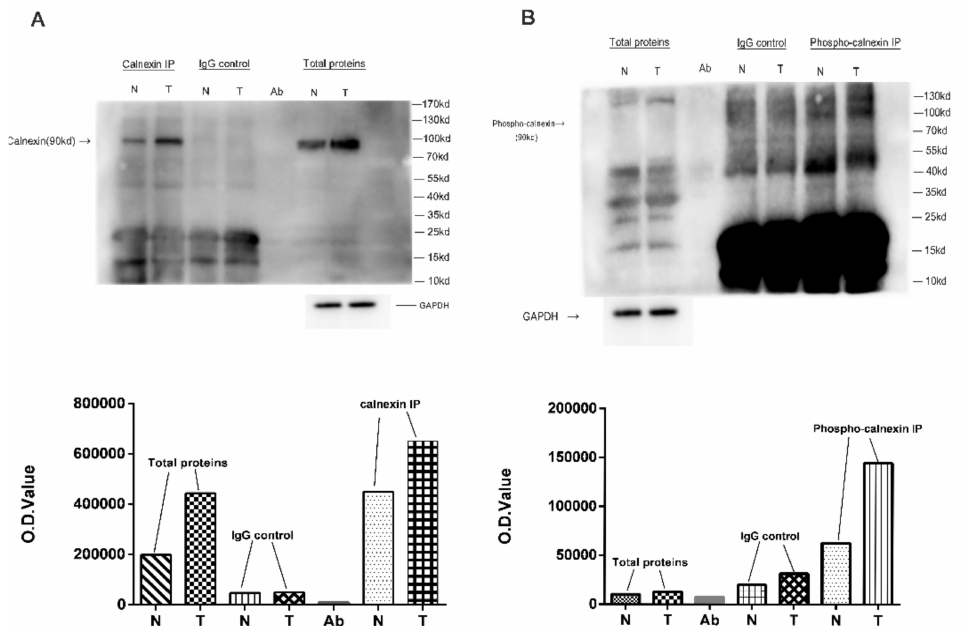
Figure 5. Semiquantitative analysis of phosphorylated calnexin between NF-PitNETs and controls. The total proteins were extracted from NF-PitNETs (T) and control pituitary tissues (N). Calnexin was immunoprecipitated from the total proteins (T: n = 1.5 mg; N: n = 1.5 mg) with anti-calnexin antibodies (6 µ g). For the negative control experiment to test the specificity of anti-calnexin antibodies, IgG (6 µ g) was used to replace anti-calnexin antibodies for immunoprecipitation. ( A ). Half of the IP product was used to detect the expression level of calnexin in NF-PitNETs (T) and control pituitary tissues (N) with another different anti-calnexin antibody. A portion of anti-calnexin antibodies (Ab: n = 1 µ g) and total proteins (N: n = 20 µ g; T: n = 20 µ g) were used as the control to immunoblot with another different anti-calnexin antibody. ( B ). Half of the IP product was used to detect the phosphorylation level of calnexin in NF-PitNETs (T) and control pituitary tissues (N) with anti-phosphoserine antibodies. A portion of anti-calnexin antibodies (Ab: n = 1 µ g) and total proteins (N: n = 20 µ g; T: n = 20 µ g) were used as control to immunoblot with anti-phosphoserine